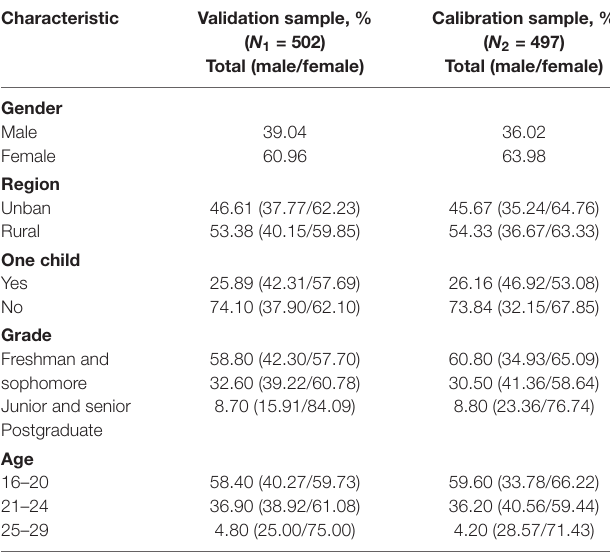
TABLE 1 | Demographic characteristics of the calibration sample and the validation